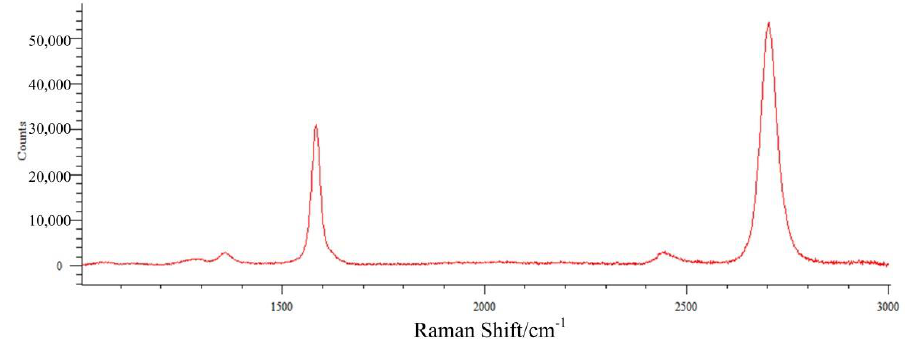
Figure 6. The graphene ’ s Raman spectrum on the silicone substrate area.